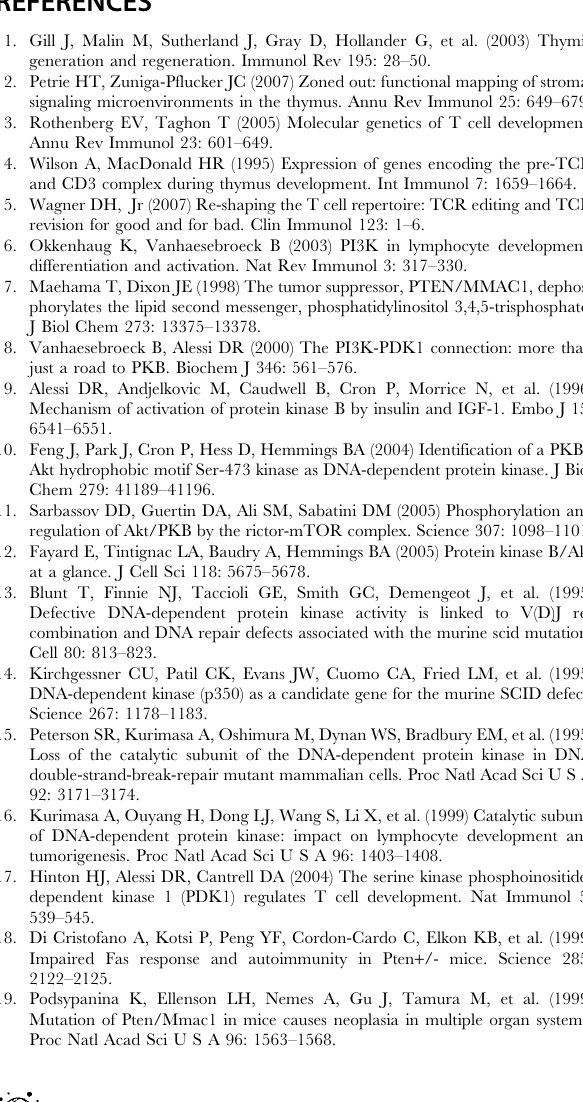
Figure S2 FACS analysis of different thymocyte subsets. A: Density plots show the main thymocyte subsets from PKB a + / + and PKB a 2 / 2 mice: DN (CD4 2 CD8 2 ), DP (CD4 + CD8 + ), SP CD4 + (CD4 + CD8 2 ), and SP CD8 + (CD4 2 CD8 + ). The results shown are representative of three independent experiments on 4 to 6 week- old mice. B: Histograms show the intracellular protein expression of TCR b (iTCR b ) in DN4 thymocytes from PKB a + / + and PKB a 2 / 2 mice. C–D: Histograms show BrdU incorporation (C) or annexin V staining (D) in specific thymocyte subsets from PKB a + / + and PKB a 2 / 2 mice. Figure S3 The deletion of PKB a tends to lead to disorganized thymic structures in neonates. A–B: Hematoxylin and eosin staining of 5 m m-thick sections from formalin-fixed paraffin- embedded mouse thymi from (A) PKB a + / + and PKB a 2 / 2 littermates at neonatal and adult ages and (B) PKB b + / + , PKB b 2 / 2 , PKB c + / + , and PKB c 2 / 2 neonatal littermates. The bar shown on the pictures represents 200 m m. C: